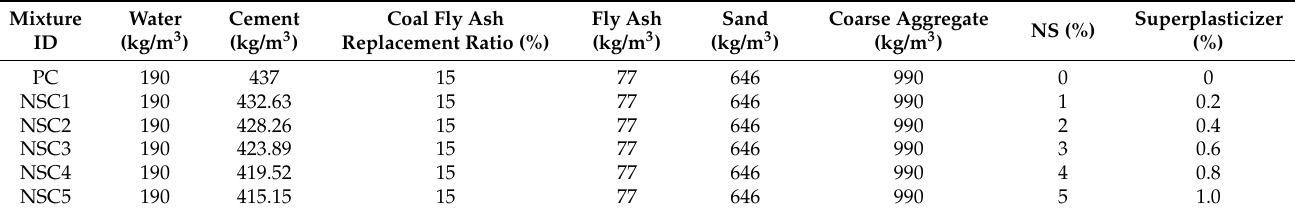
Table 7. Concrete mix